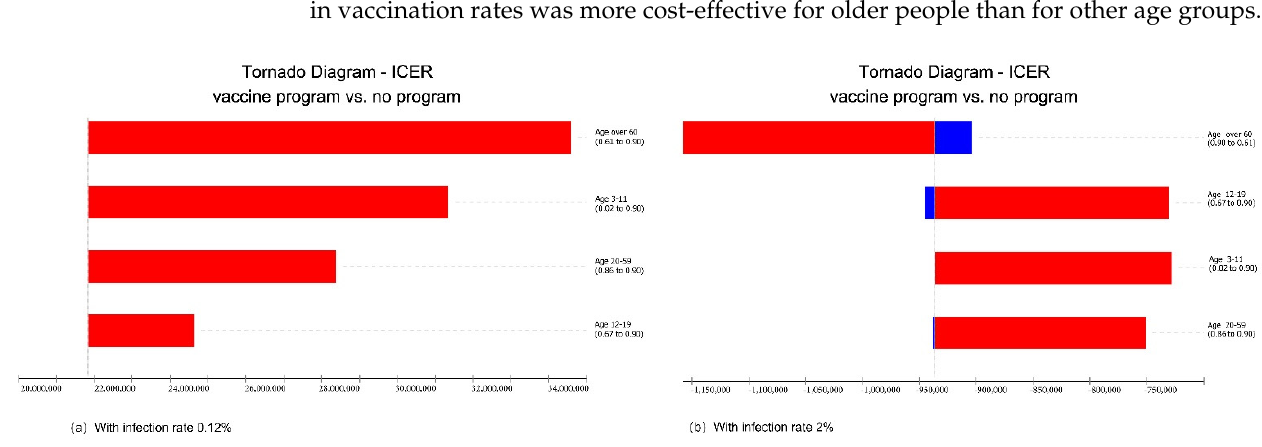
Figure 3. Tornado diagram of a one-way sensitivity analysis of vaccination rates by age group.